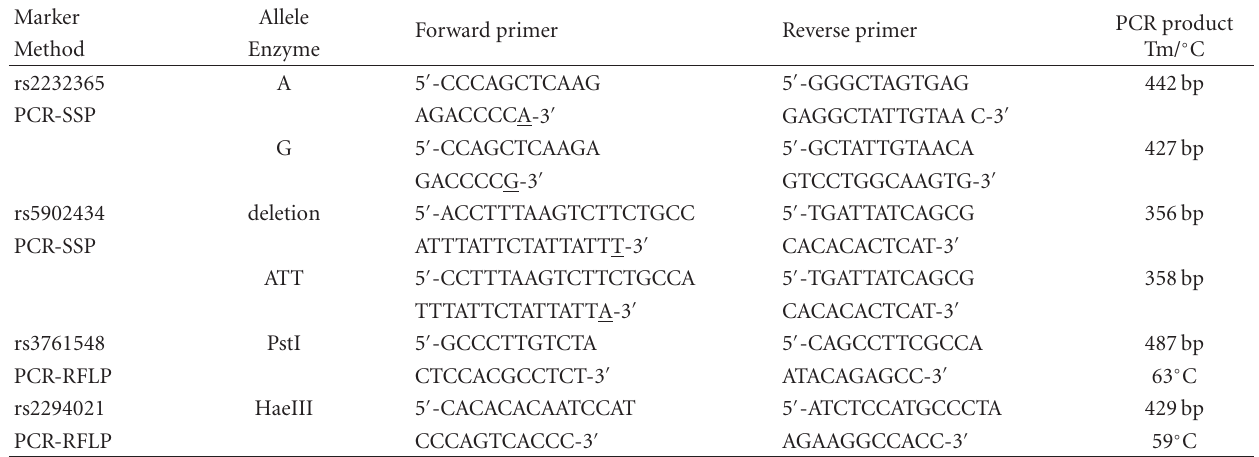
Table 1: Primers used in the genotyping by PCR-SSP or